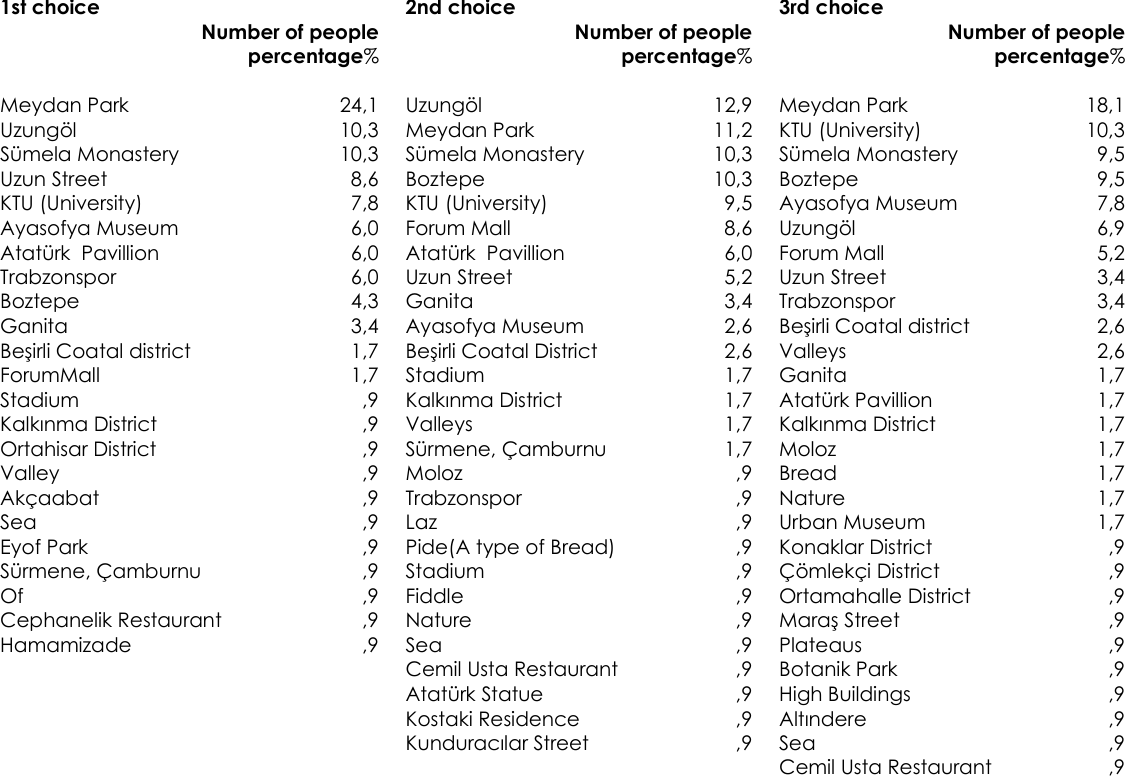
Table 7. The percentage (%) distribution of place/structure/item preferences that define Trabzon in order of importance of the participants. S10.Describe the Trabzon places/structure/elements (3 words in order of